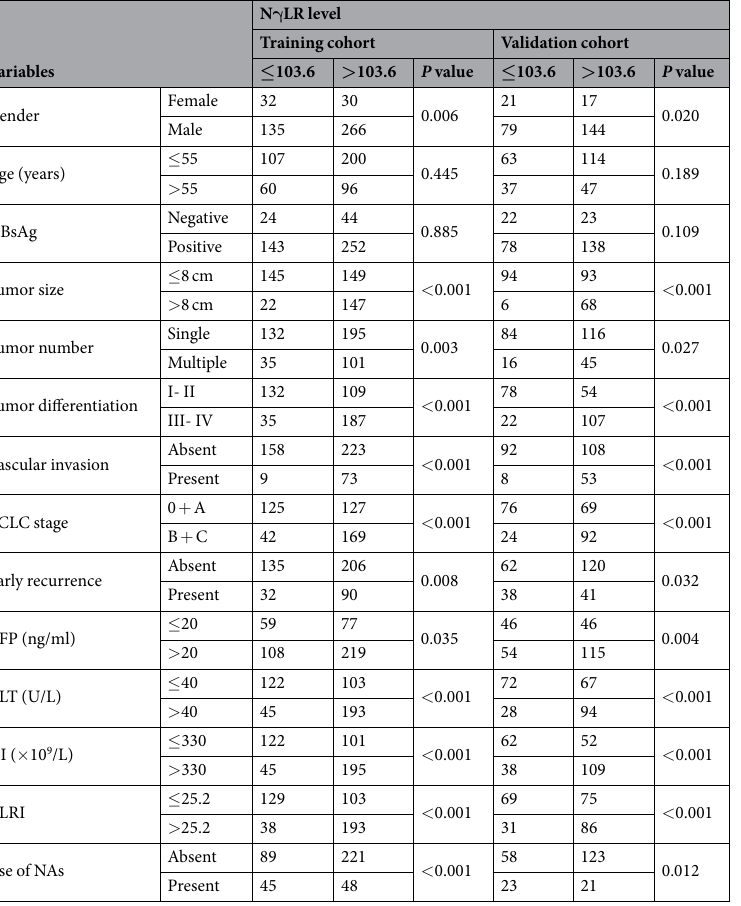
Table 2. Correlation between the clinicopathologic variables and N γ LR level in HCC patients (training cohort, n = 463 and validation cohort, n = 261). N γ LR, neutrophil cell count times γ -glutamyl